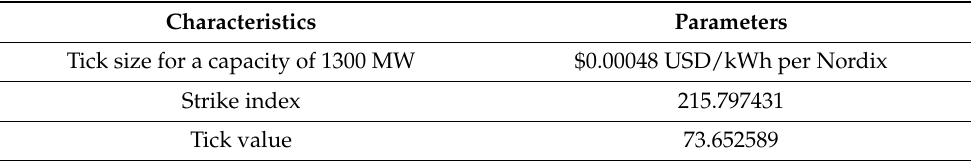
Table 5. Parameters for the European wind put barrier